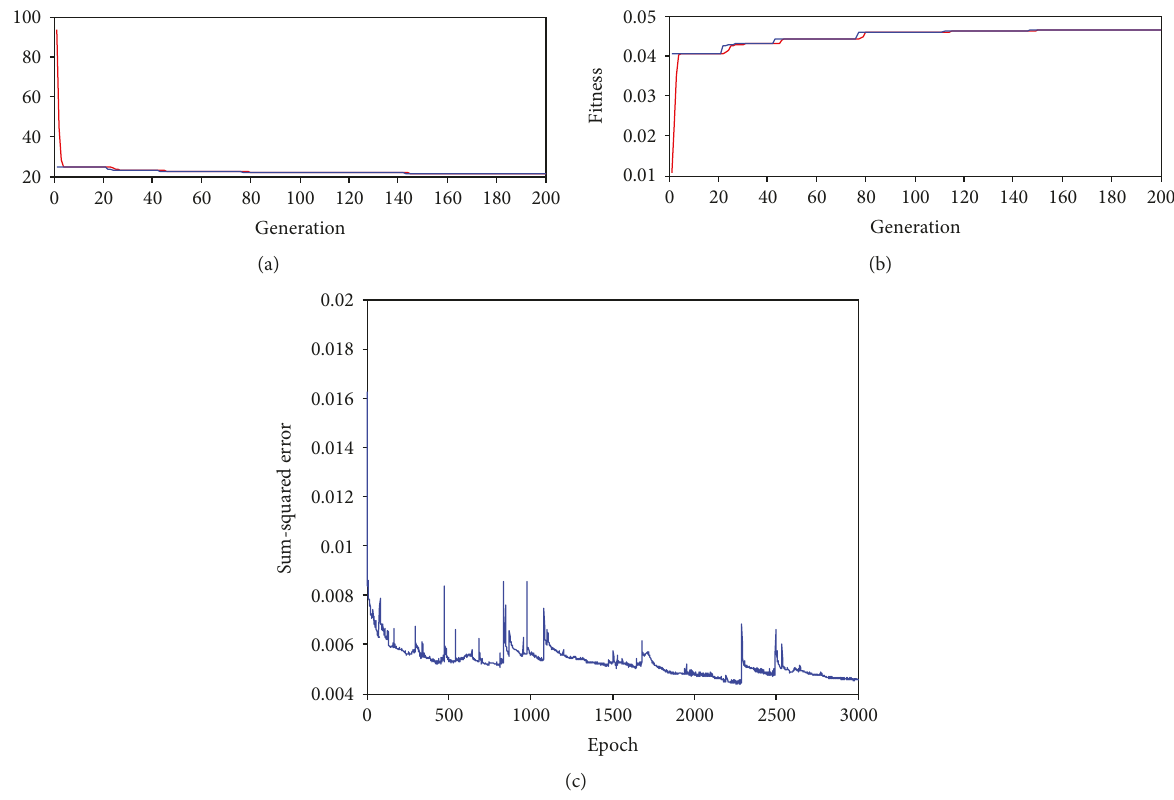
Figure 4: Training performance of FWNN based on hybrid GA-GDA